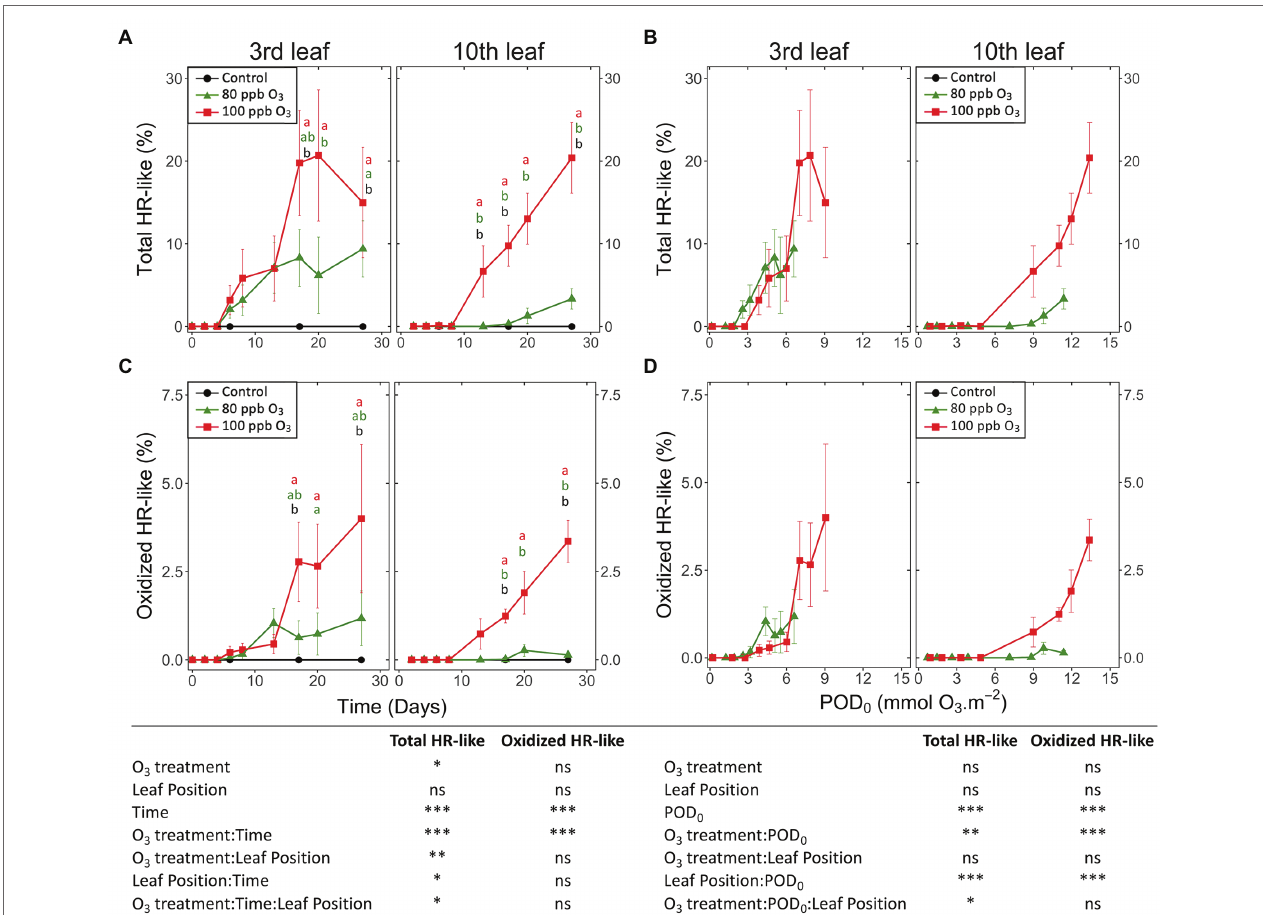
FIGURE 5 | Development dynamics of HR-like lesions (A,B) and lesion oxidation (C,D) in hybrid poplar leaves ( Populus tremula x alba ), as a function of the assessment time (A,C) , phytotoxic O 3 dose (POD 0 ; B,D ), O 3 treatment (charcoal-filtered air ● , 80 ppb O 3 ▲ , 100 ppb O 3 ◼ ), leaf position and interactions {model: lmer[sqrt(variable)] ~ O 3 treatment ∗ leaf position ∗ time + (1 | tree / chamber); ∗∗∗ p ≤ 0.001; ∗∗ p ≤ 0.01; ∗ p ≤ 0.05; ns, not significantly different}. Values represent means ± SE of percentage area of leaf discs showing microscopic injury, n = 4. Different letters indicate significant differences between treatments at a given assessment date ( post-hoc Tukey’s honest significant difference, p ≤